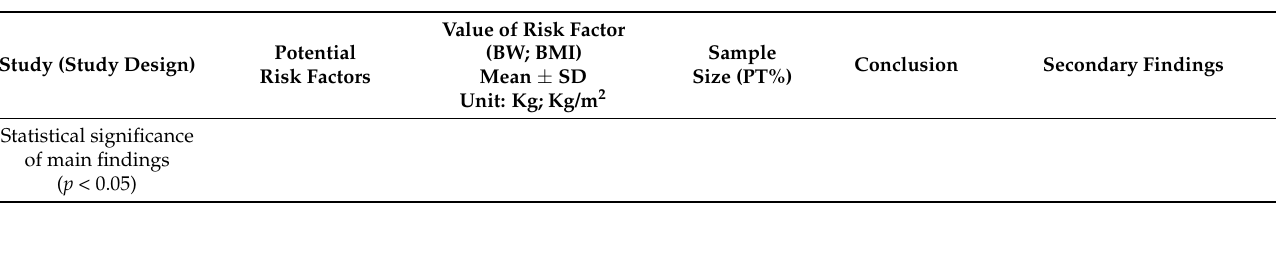
Table 3. Summary of results of individual studies